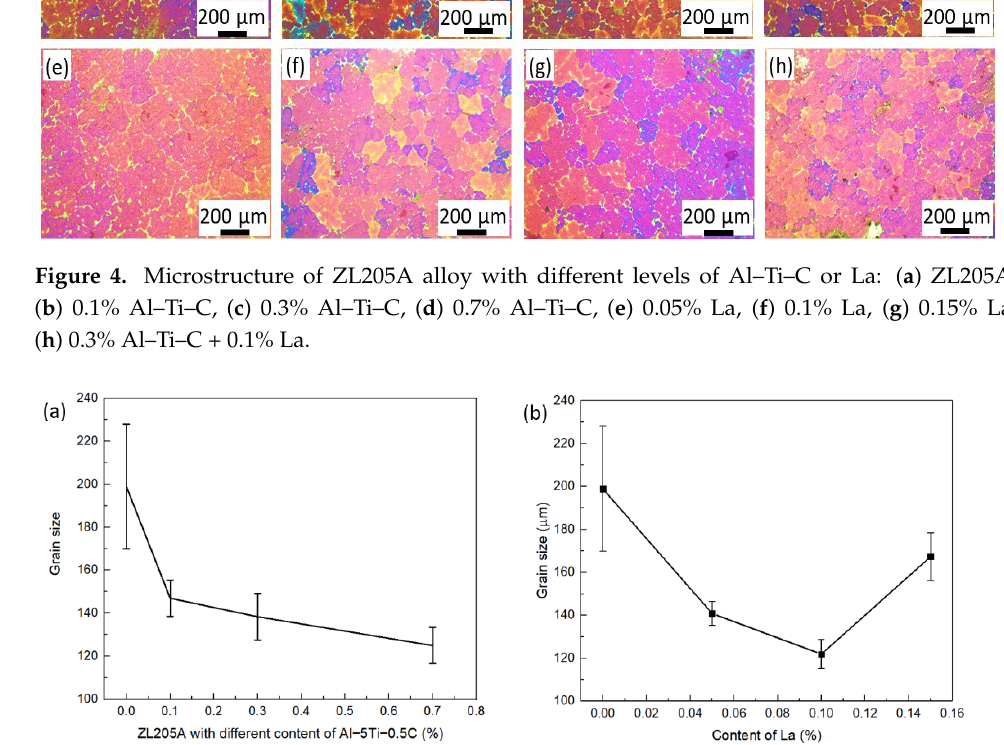
Figure 5. Evolution of grain size with the addition of ( a ) Al−Ti−C and ( b ) La. The microstructure of the ZL205A fluidity test sample demonstrated equiaxed dendrite near the sand mold wall, as opposed to columnar dendrite; therefore, the solidification progressed not through the advancement of the planar interface, but in a bulk manner